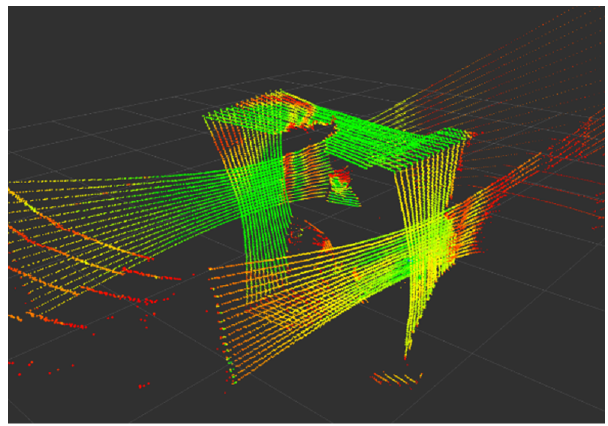
Figure 3. Dual lidar point clouds’ information after external parameter calibration.